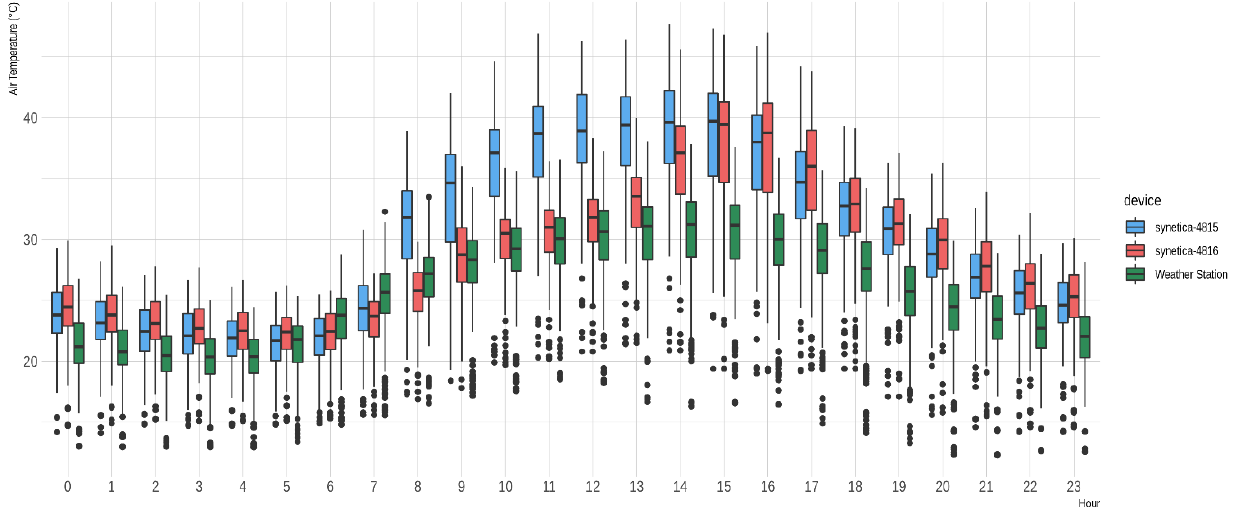
Figure 8. Hourly statistics over the period from 1 June to 27 July for the weather station and the air-quality sensors.